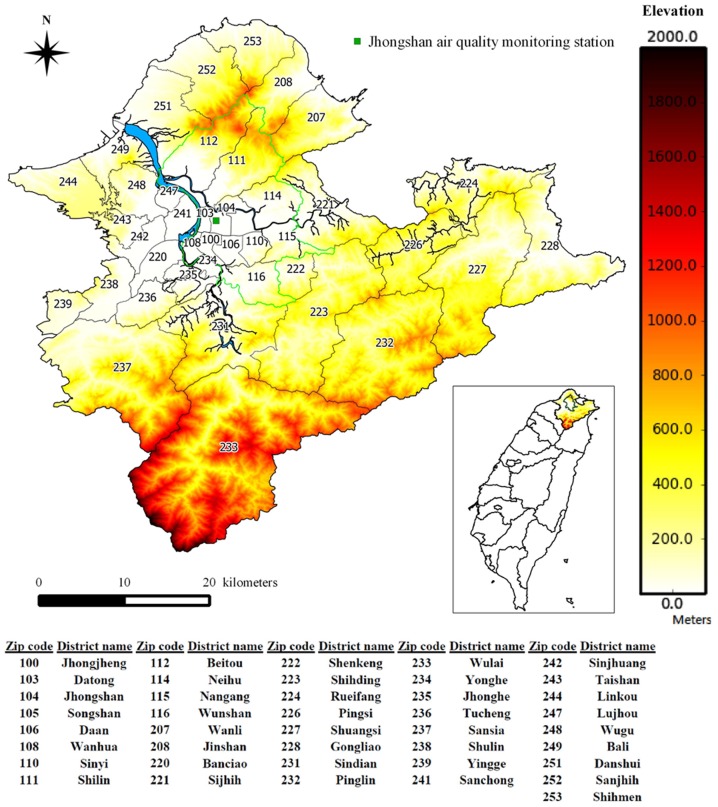
Map of Taipei City (surrounded by green boundaries) and New Taipei City, along with the map of their geographical locations in the Taiwan Island.The district names are denoted by their zip codes with the names shown at the table below. The Jhongshan air quality monitoring station is highlighted by a green square.